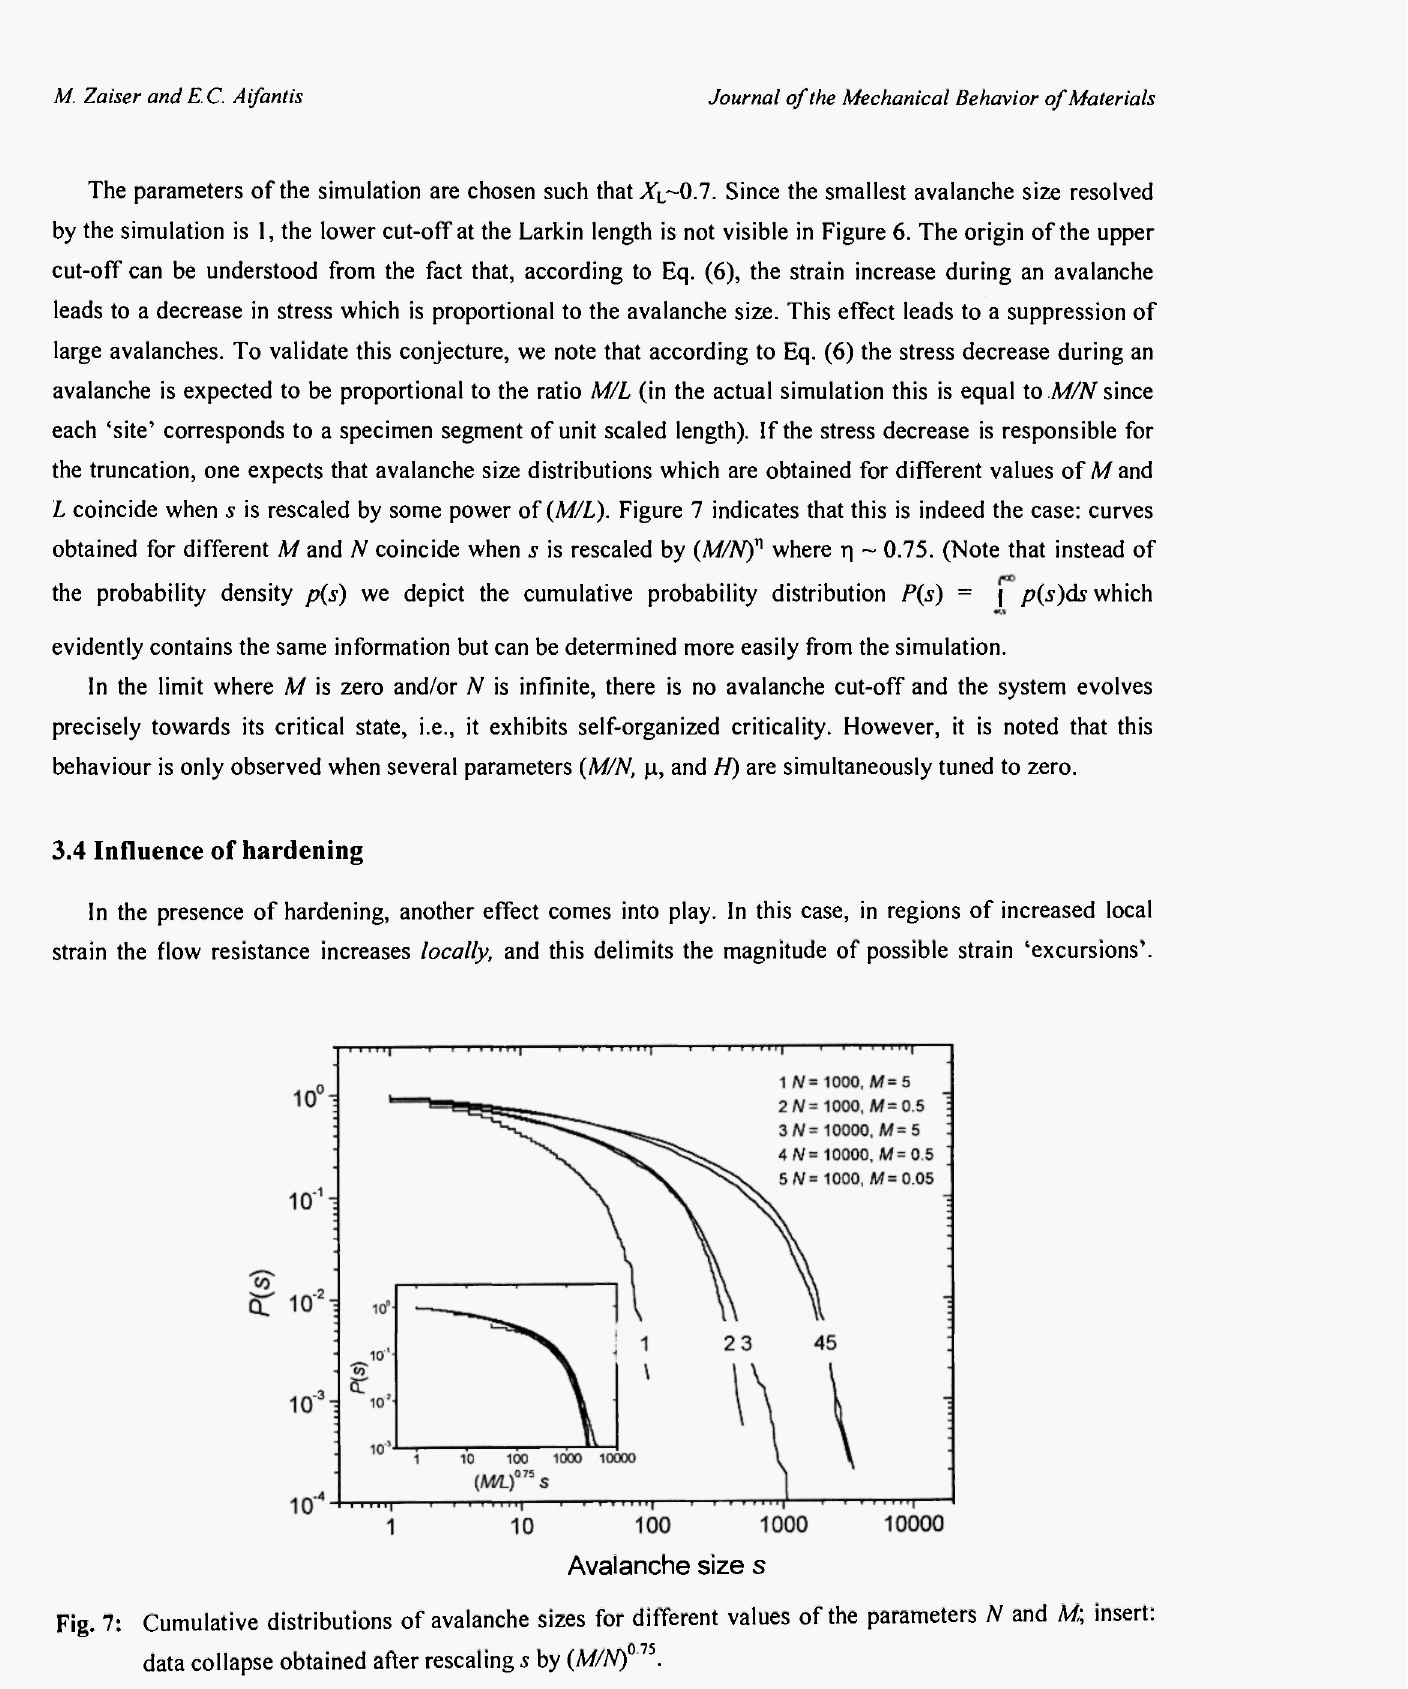
Fig. 7: Cumulative distributions of avalanche sizes for different values of the parameters Ν and M\ insert: data collapse obtained after rescaling s by (M/N) 015